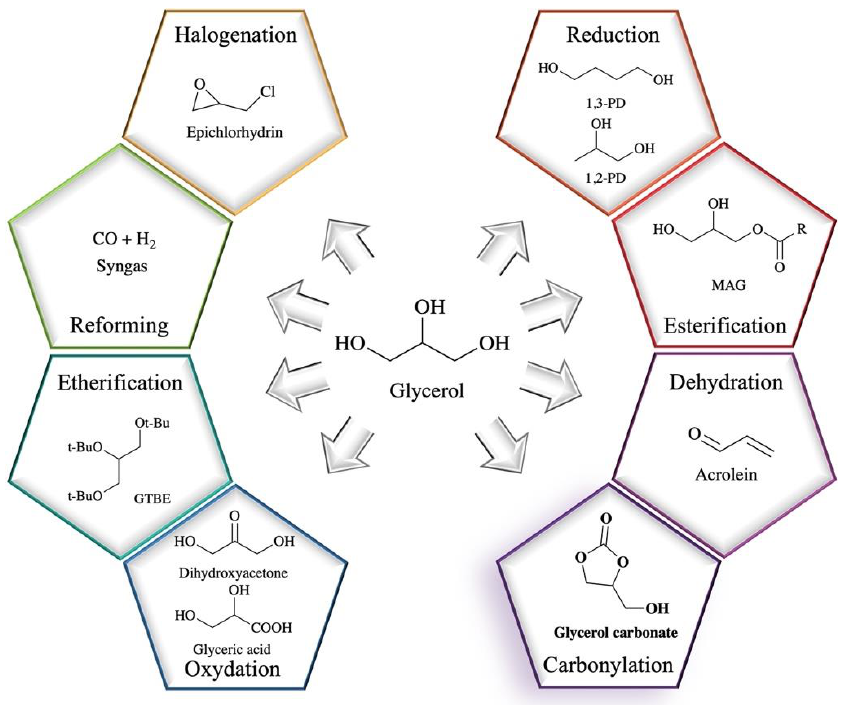
Figure 1. Main synthetic processes and high value-added chemicals obtained from glycerol valori- zation.